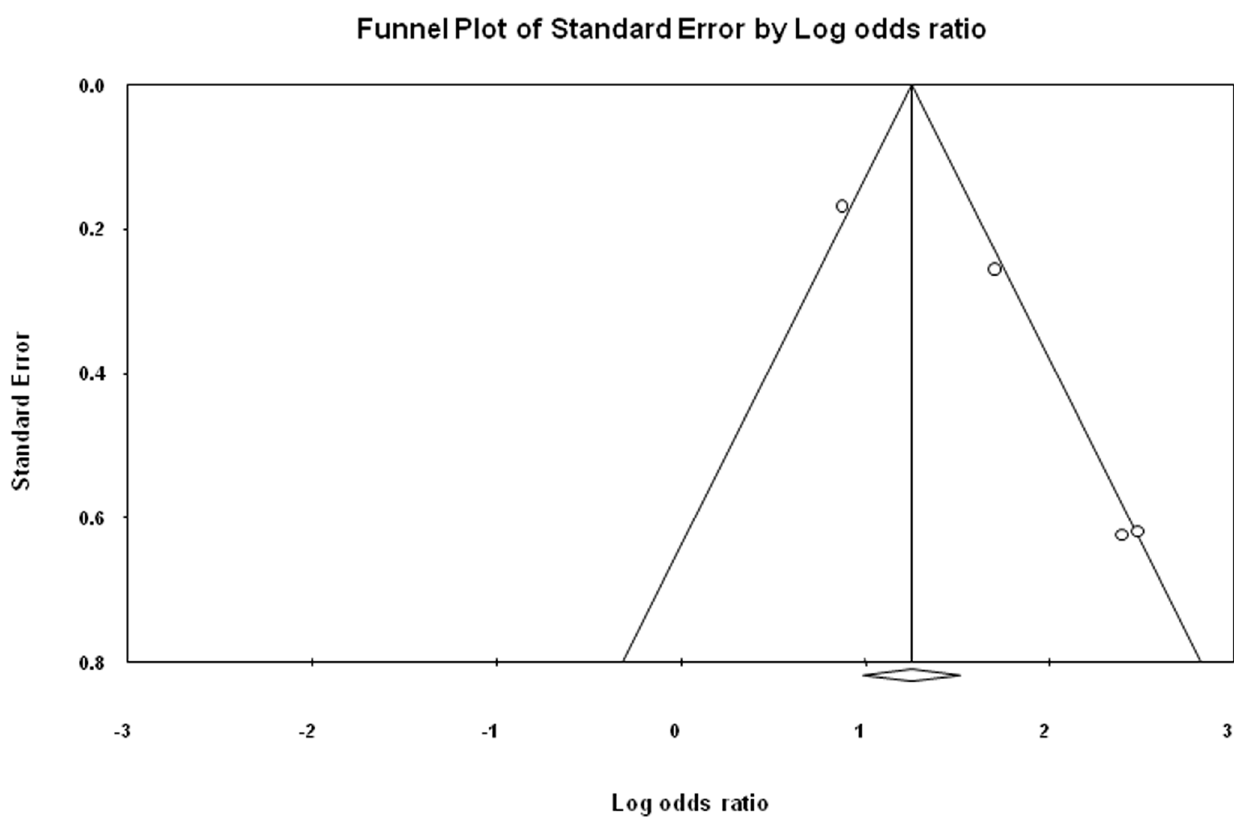
Figure 7. Publication bias for cohort studies illustrating the relationship ST NOS and incidence of oral cancer. doi:10.1371/journal.pone.0113385.g007 df =13 and P-value = 0.03 (Figure 6). Egger’s regression intercept was 3.62, standard error = 1.286, 95% CI were 1.19–9.16,